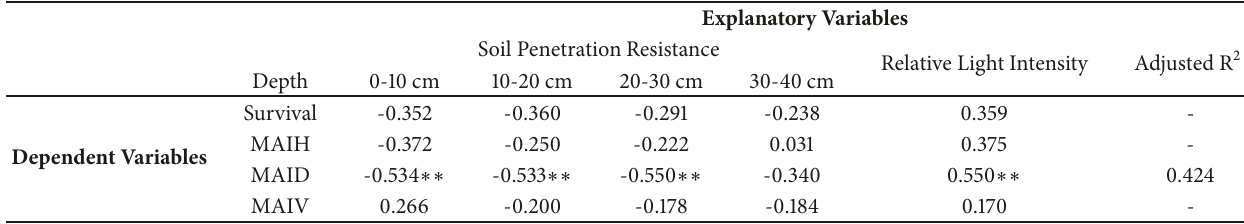
Figure6:Relationshipbetweenmeanannualincrementindiameteratbreastheightwithsoilpenetrationresistanceandrelativelightintensity. ∗∗ : correlation is significant at P < 0.01, using Pearson correlation matrix. Table 4: Stepwise multiple regression analysis on the survival and tree growth parameters (MAIH, MAID, and MAIV) in relation to explanatory environmental factors (soil compaction and relative light